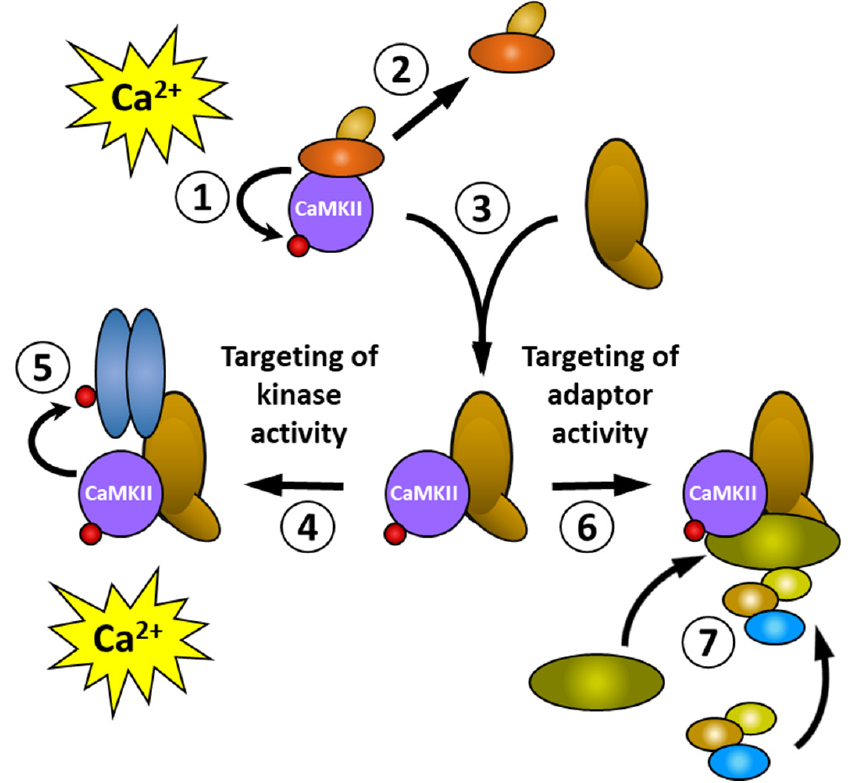
Figure 2. Targeting can produce localised functional outcomes by altering the kinase or adaptor activity of CaMKII. Coloured oblong shapes represent generic proteins with which CaMKII (purple disc) binds directly or indirectly. The small red disc represents the phosphorylation of a protein. See text for explanation of the sequence of events shown in the